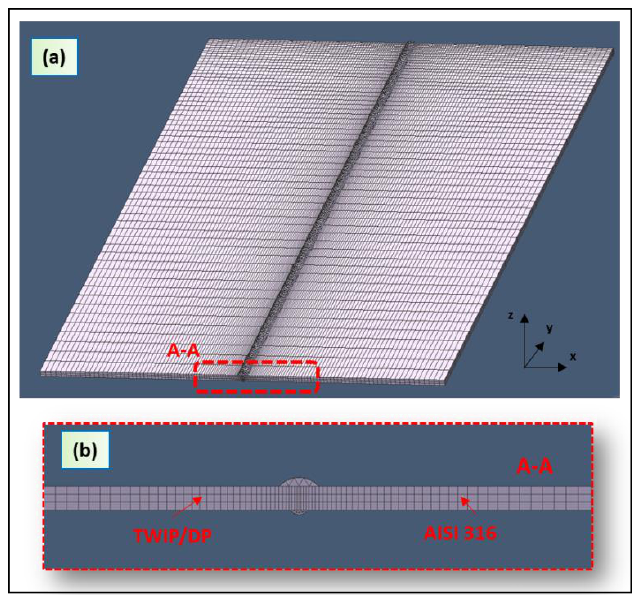
Figure 3. ( a ) Finite element model (FEM) used in the hybrid laser-arc welding; ( b ) side view